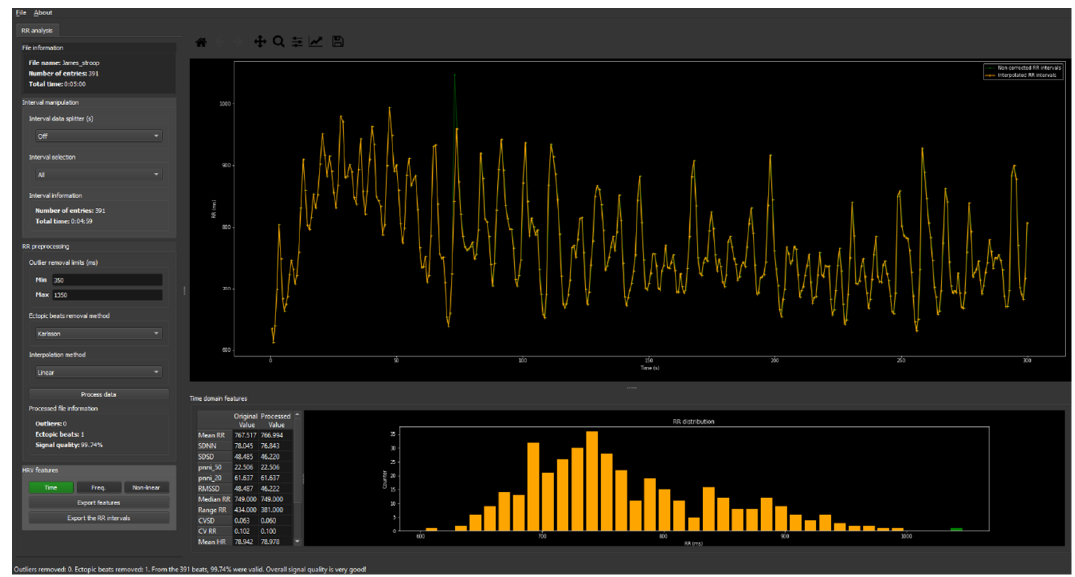
Figure 3. The interface of the software developed for the detection and correction of abnormal intervals.